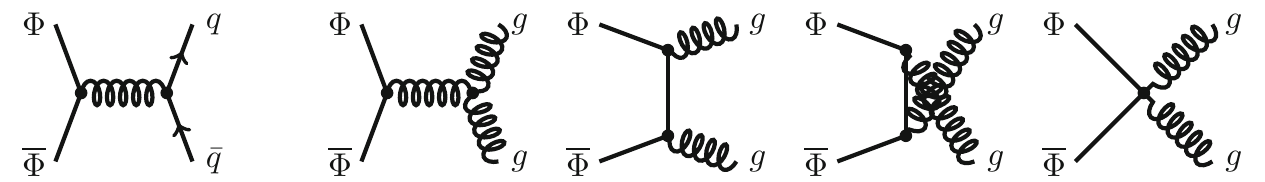
Fig. 2 Feynman diagrams for the annihilation of (cid:2) into either a quark–anti-quark pair or a pair of gluons. The annihilating field (cid:2) may be scalar, fermion or vector, however, in the case of the fermion the four-point interaction is absent channel of the cross section will then be corrected